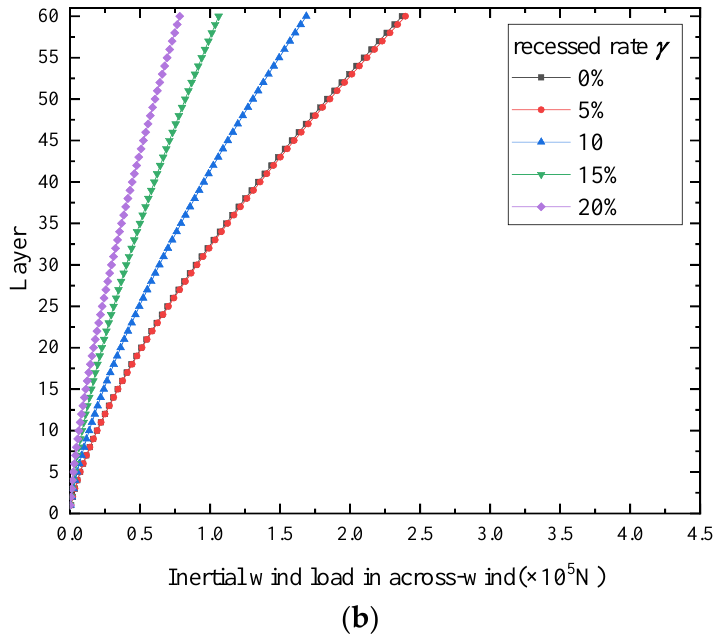
Figure 17. The inertial wind loads. ( a ) Along-wind inertial wind loads. ( b ) Across-wind inertial wind loads.